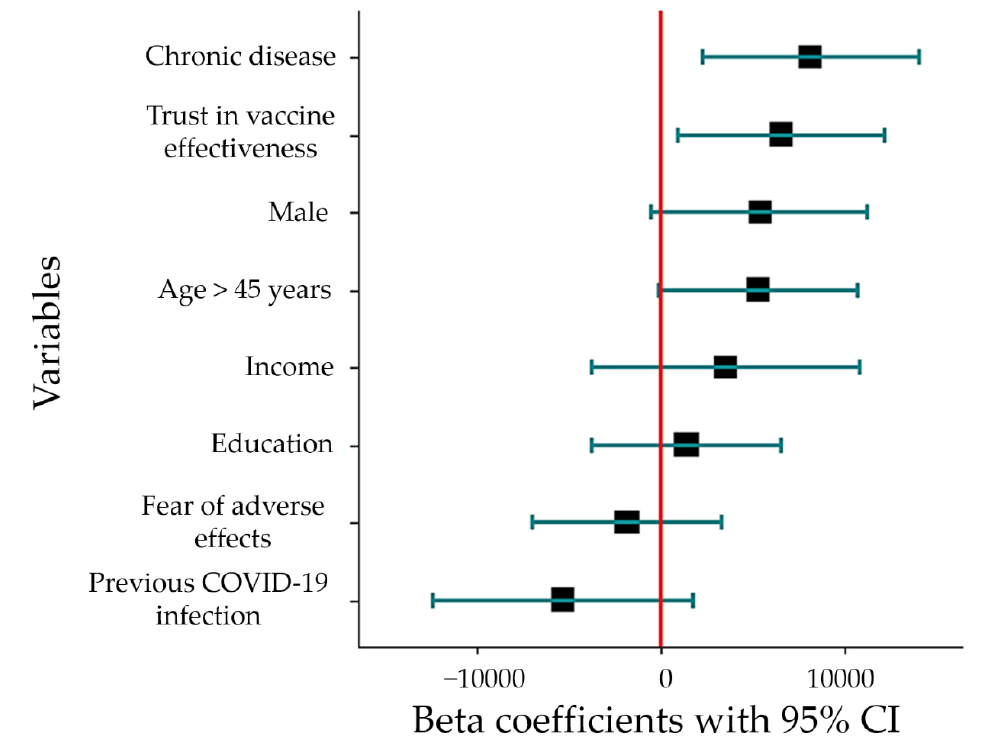
Figure 11. The predictors of COVID-19 vaccine booster dose acceptance.